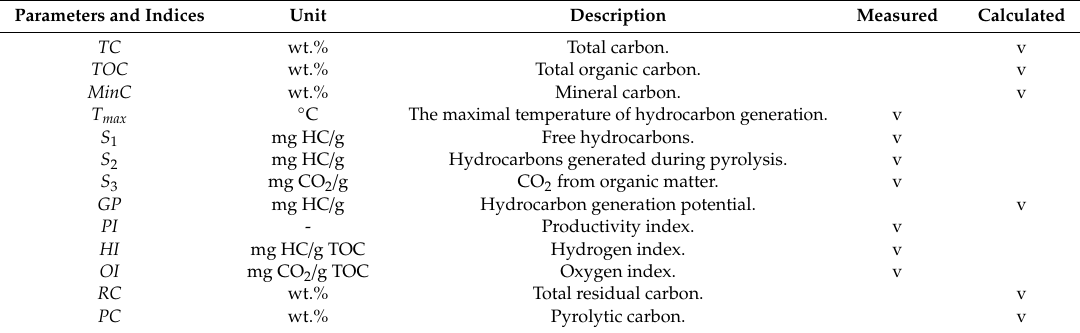
Table 2. The measured parameters and calculated indices of Rock − Eval 6